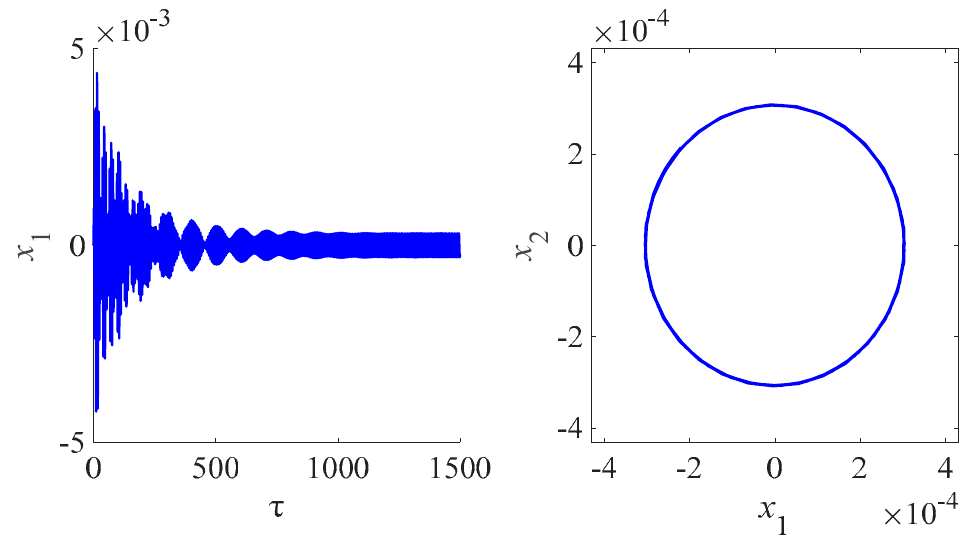
Figure 7. Time domain and frequency domain diagram for PDJJ for the magnetic field 6 T.